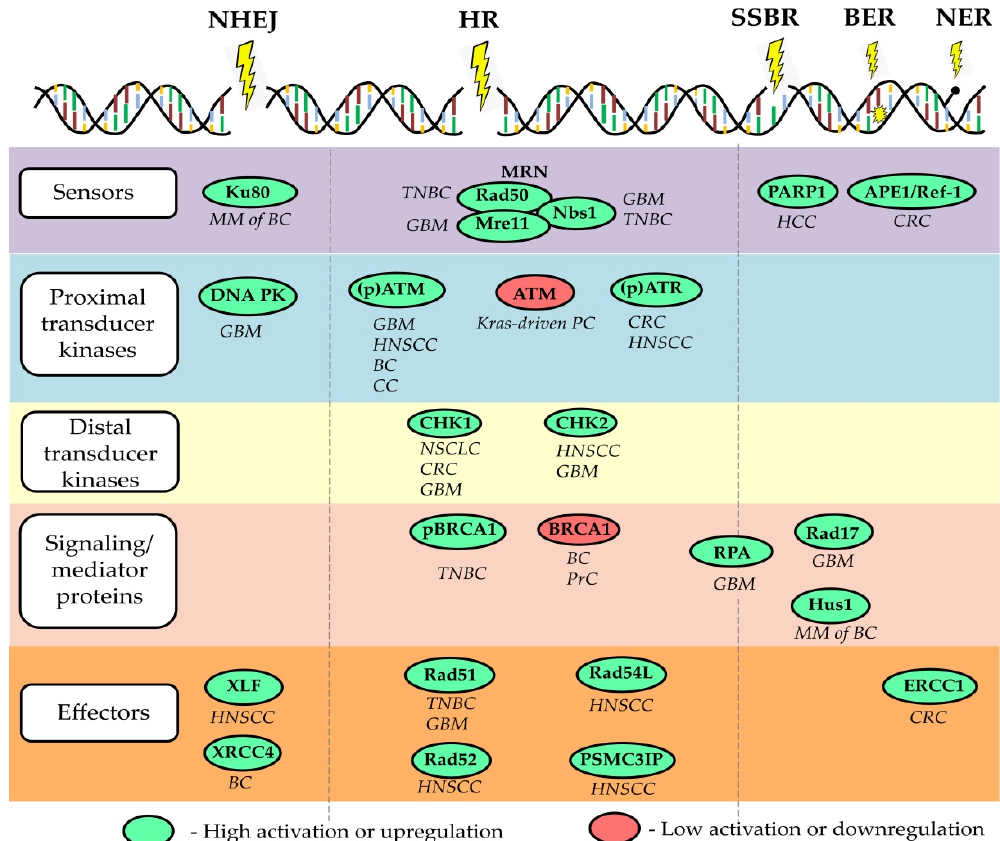
Figure 2. Deregulation of DNA repair proteins in cancer stem cells (CSCs) (examples). Deregulated proteins are involved in the non-homologous DNA end-joining (NHEJ) [87,201–204], homologous recombination (HR)—mediated DNA repair [15,30,38,86,87,196,197,203–209] and DNA single-strand break repair (SSBR)/base excision repair (BER)